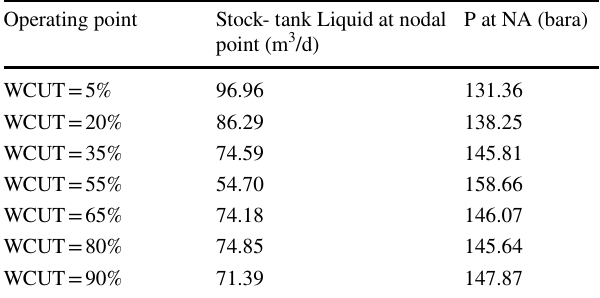
Table 6 The results from water cut effect analysis Operating